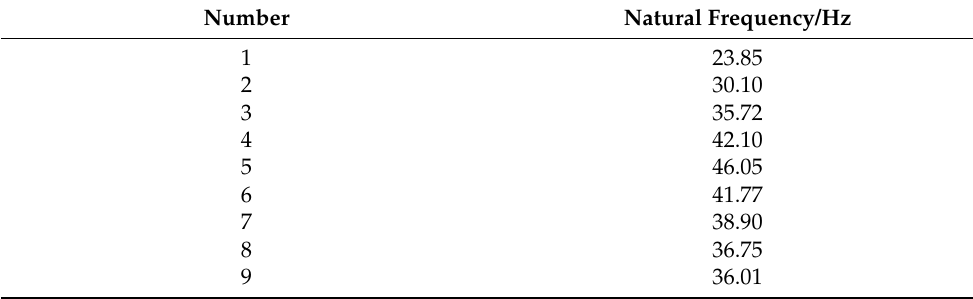
Table 5. Natural frequencies remeasured of workpieces in Table